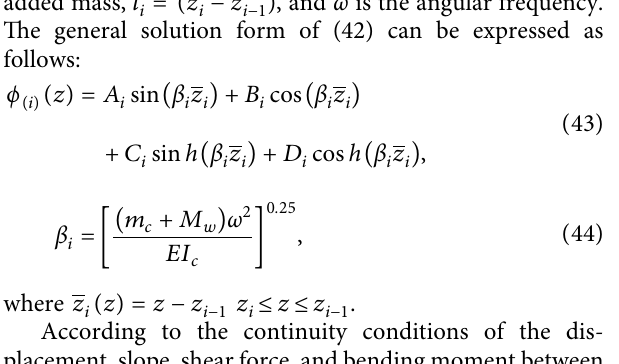
l for different values of H with σ 3 versus 0